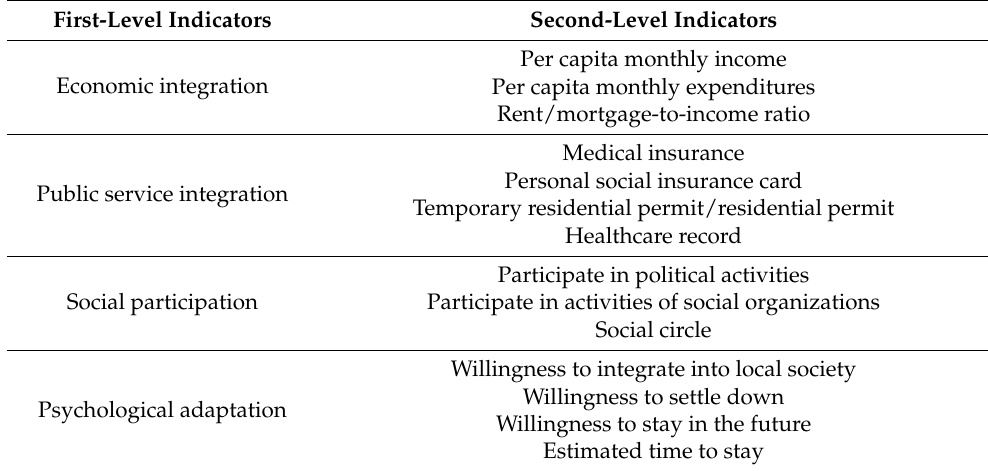
Table 1. Indicator system of migrants’ social